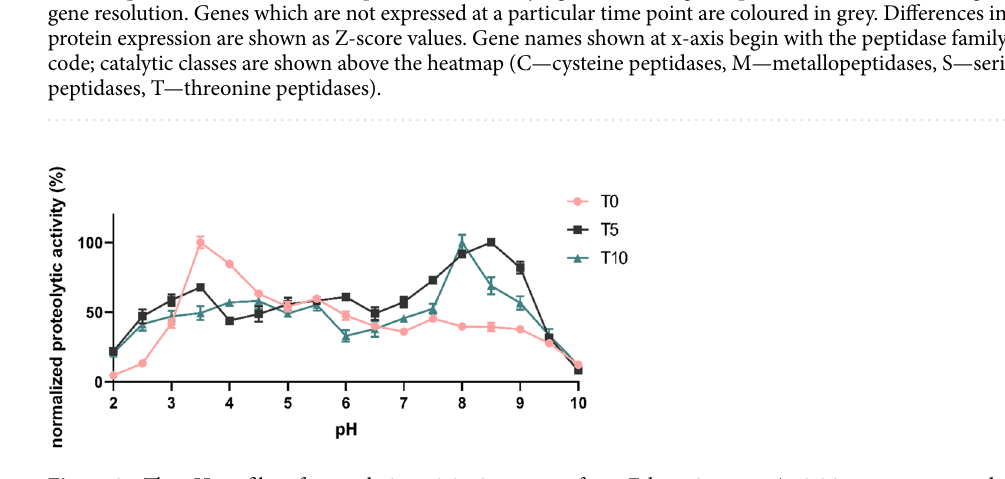
Figure 9. The pH profiles of proteolytic activity in extracts from F. hepatica eggs. Activities were measured using a library of FRET substrates in extracts from eggs collected 0, 5, and 10 days after laying (T0, T5, and T10, respectively). Data were normalised against the highest proteolytic activity recorded for each protein sample. Mean values are listed with the standard